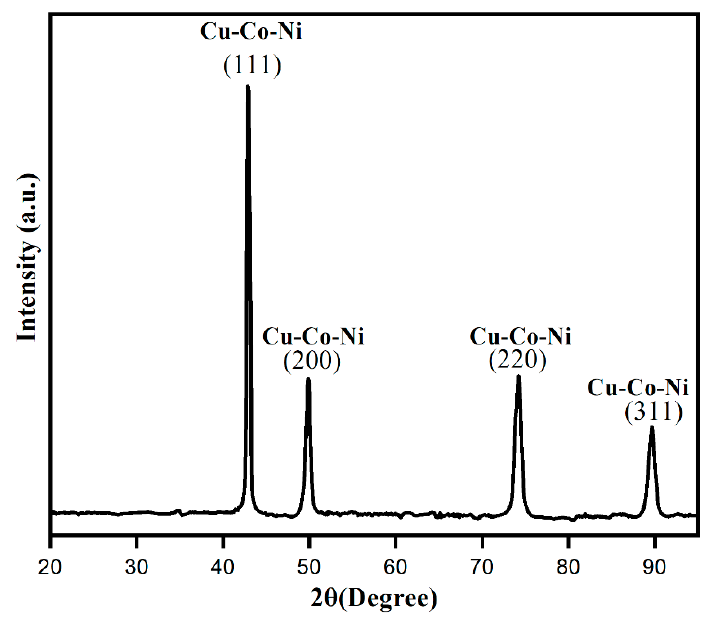
Figure 7. X-ray diffraction (XRD) patterns of biosynthesized Cu-Co-Ni trimetallic